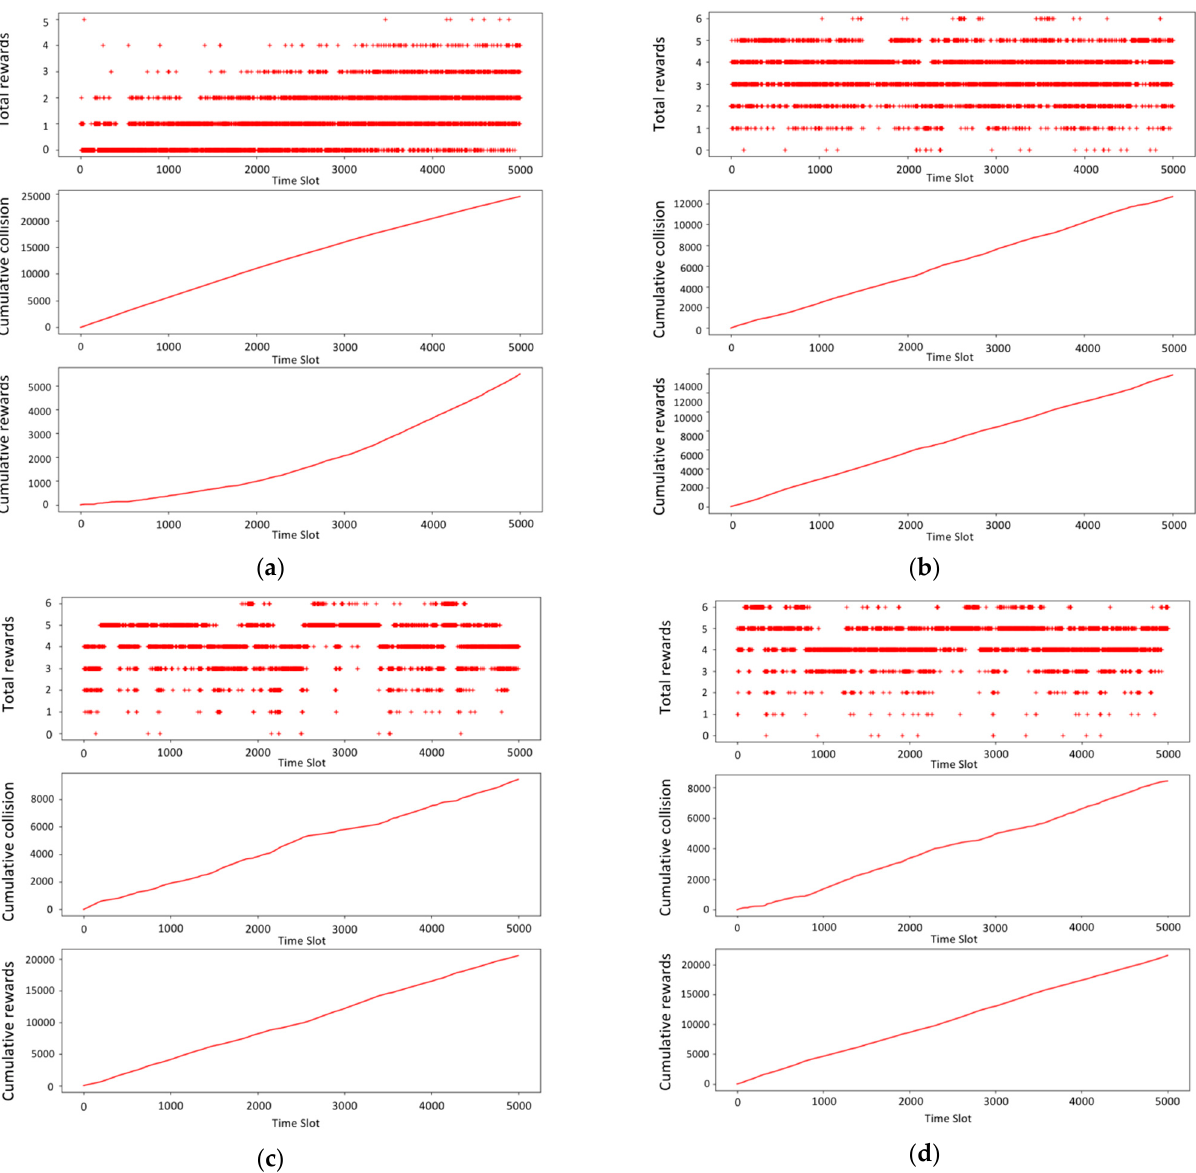
Figure 7. When K = 6 and N = 10, the total reward, cumulative collision and cumulative reward for ( a ) the first 5000 time slots ( b ) 20,000 to 25,000 time slots ( c ) 65,000 to 70,000 time slots ( d ) 95,000 to 100,000 time slots.